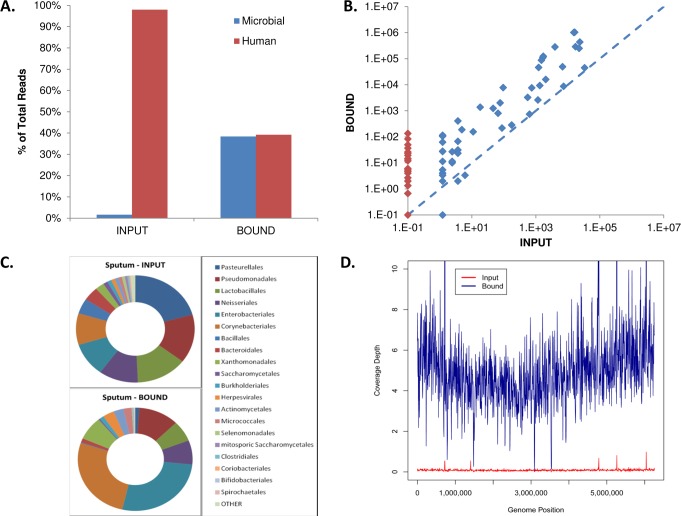
HpaII mediated enrichment of DNA from a pooled sputum sample improves microbe sequencing detection and coverage.(A) The percent of microbial ID reads (blue) increases and human ID reads (red) decrease with enrichment. (B) Normalized microbial Order sequence Identification reads are plotted for bound and input samples. Greater than 95% of identified microbes have increased sequenced reads. Many microbes (red points) are only detectable after enrichment. (C) Comparison of ratio of microbial sequence ID reads in sputum input and sputum bound samples. (D) Genomic sequencing coverage of bacteria such as P. aeruginosa improves with enrichment. The input DNA sample coverage (red line) and HpaII bound coverage (blue line) are plotted across the genome position of P. aeruginosa.